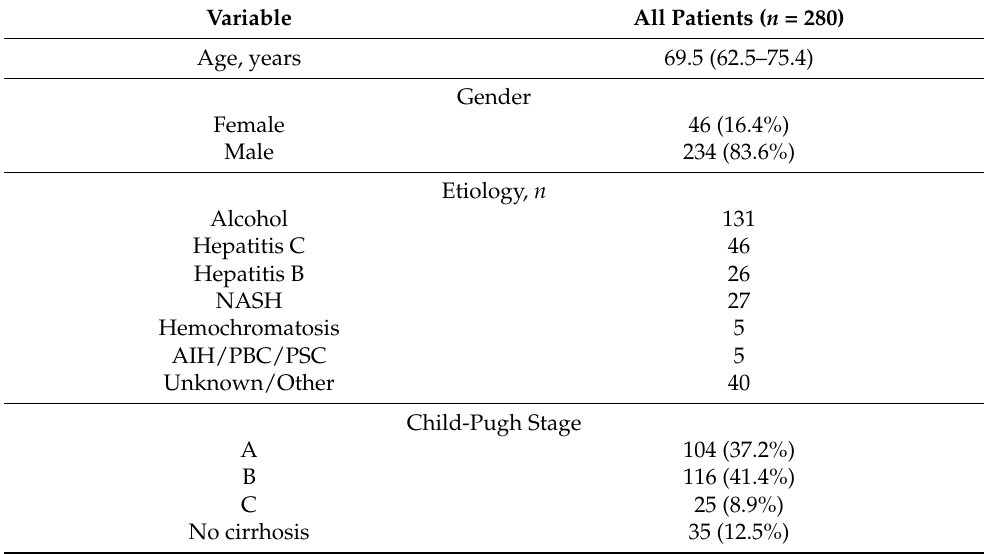
Table 1. Baseline characteristics of patients with HCC undergoing TACE included in this